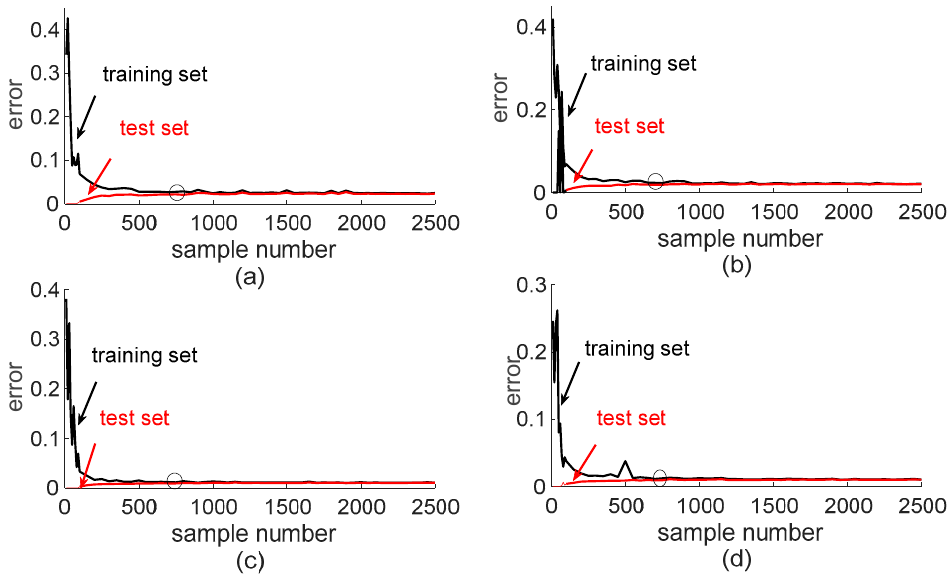
Figure 3. The trade-off of sample number and accuracy at different conditions. ( a ) 0.6 V 25 ℃ , ( b ) 0.6 V 75 ℃, ( c ) 0.8 V 25 ℃ , ( d ) 0.8 V 75 ℃ .